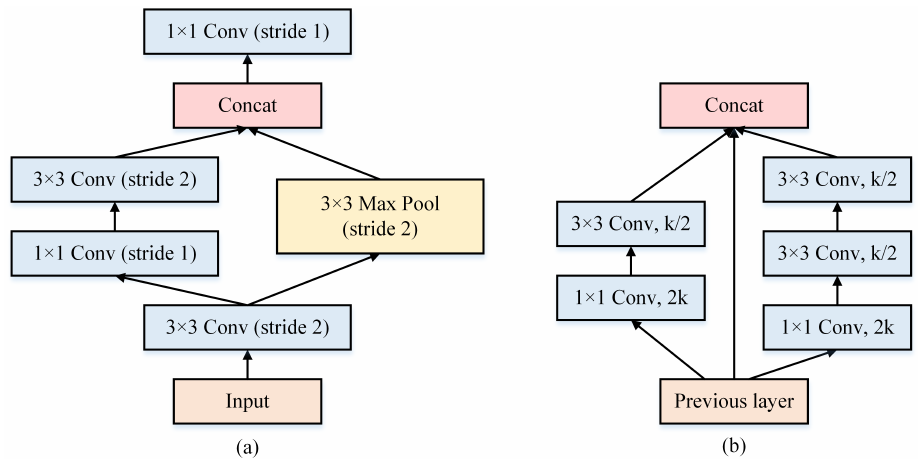
Figure 35. ( a ) Structure of stem block. ( b ) Structure of 2-way dense